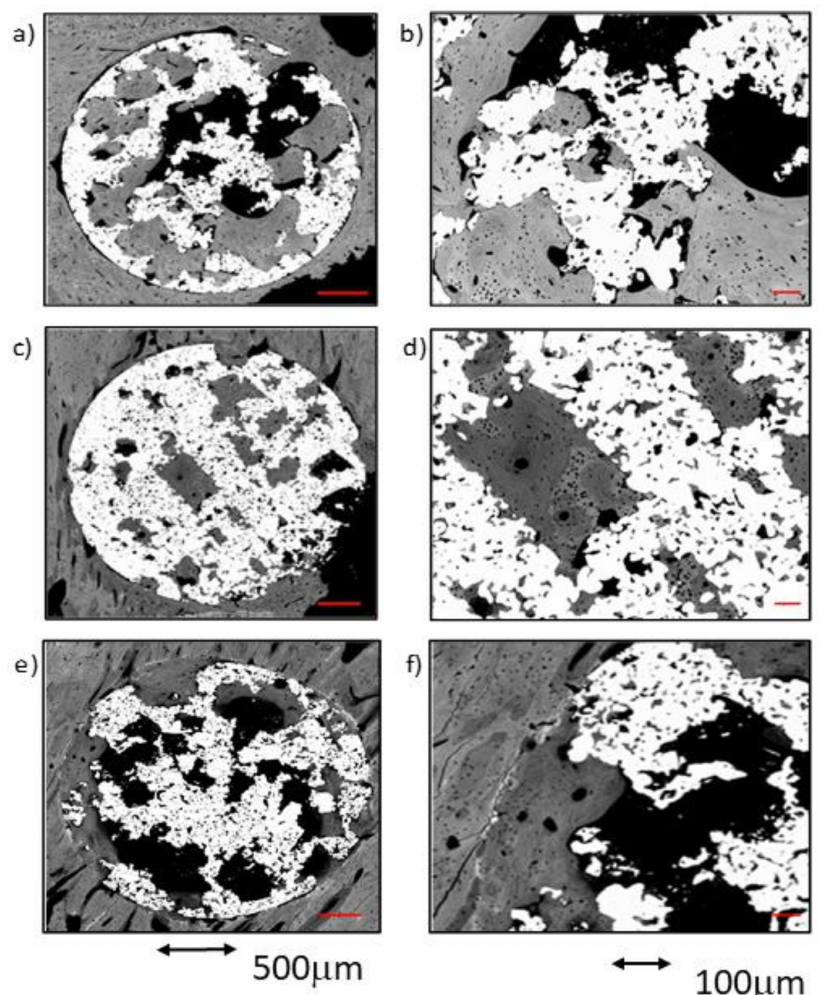
Figure 6. BSE-SEM micrographs 12 weeks after implantation in transversal section view at